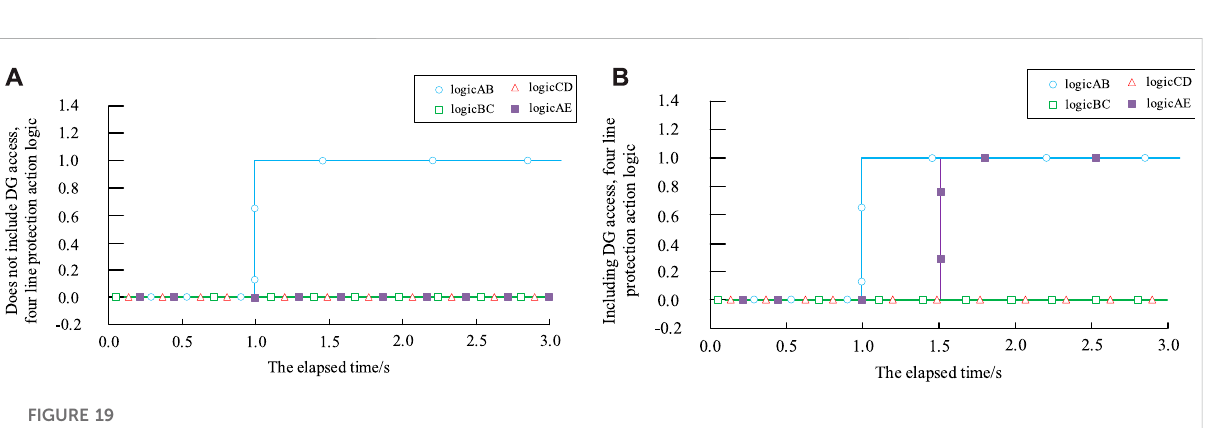
FIGURE 19 Three-stage protection action logic when three-phase short-circuit fault occurs at the AB terminal. (A) Simulation results before DG access (B) Simulation results after DG access.